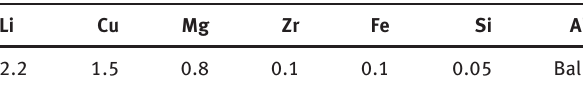
Table 2: Chemical composition of the matrix of AA8090/6% SiC composite